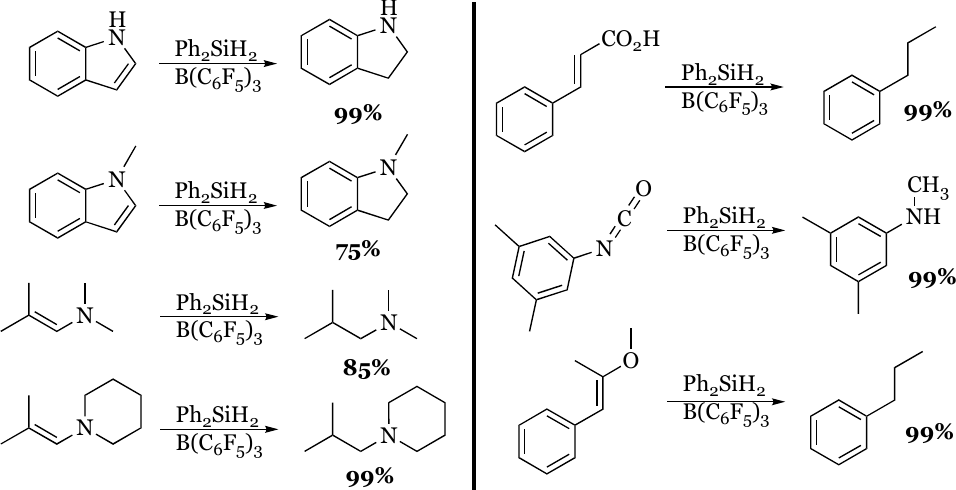
Figure 13. Reduction of indoles, enamines, cinnamic acids, isocyanates, and enol ethers.